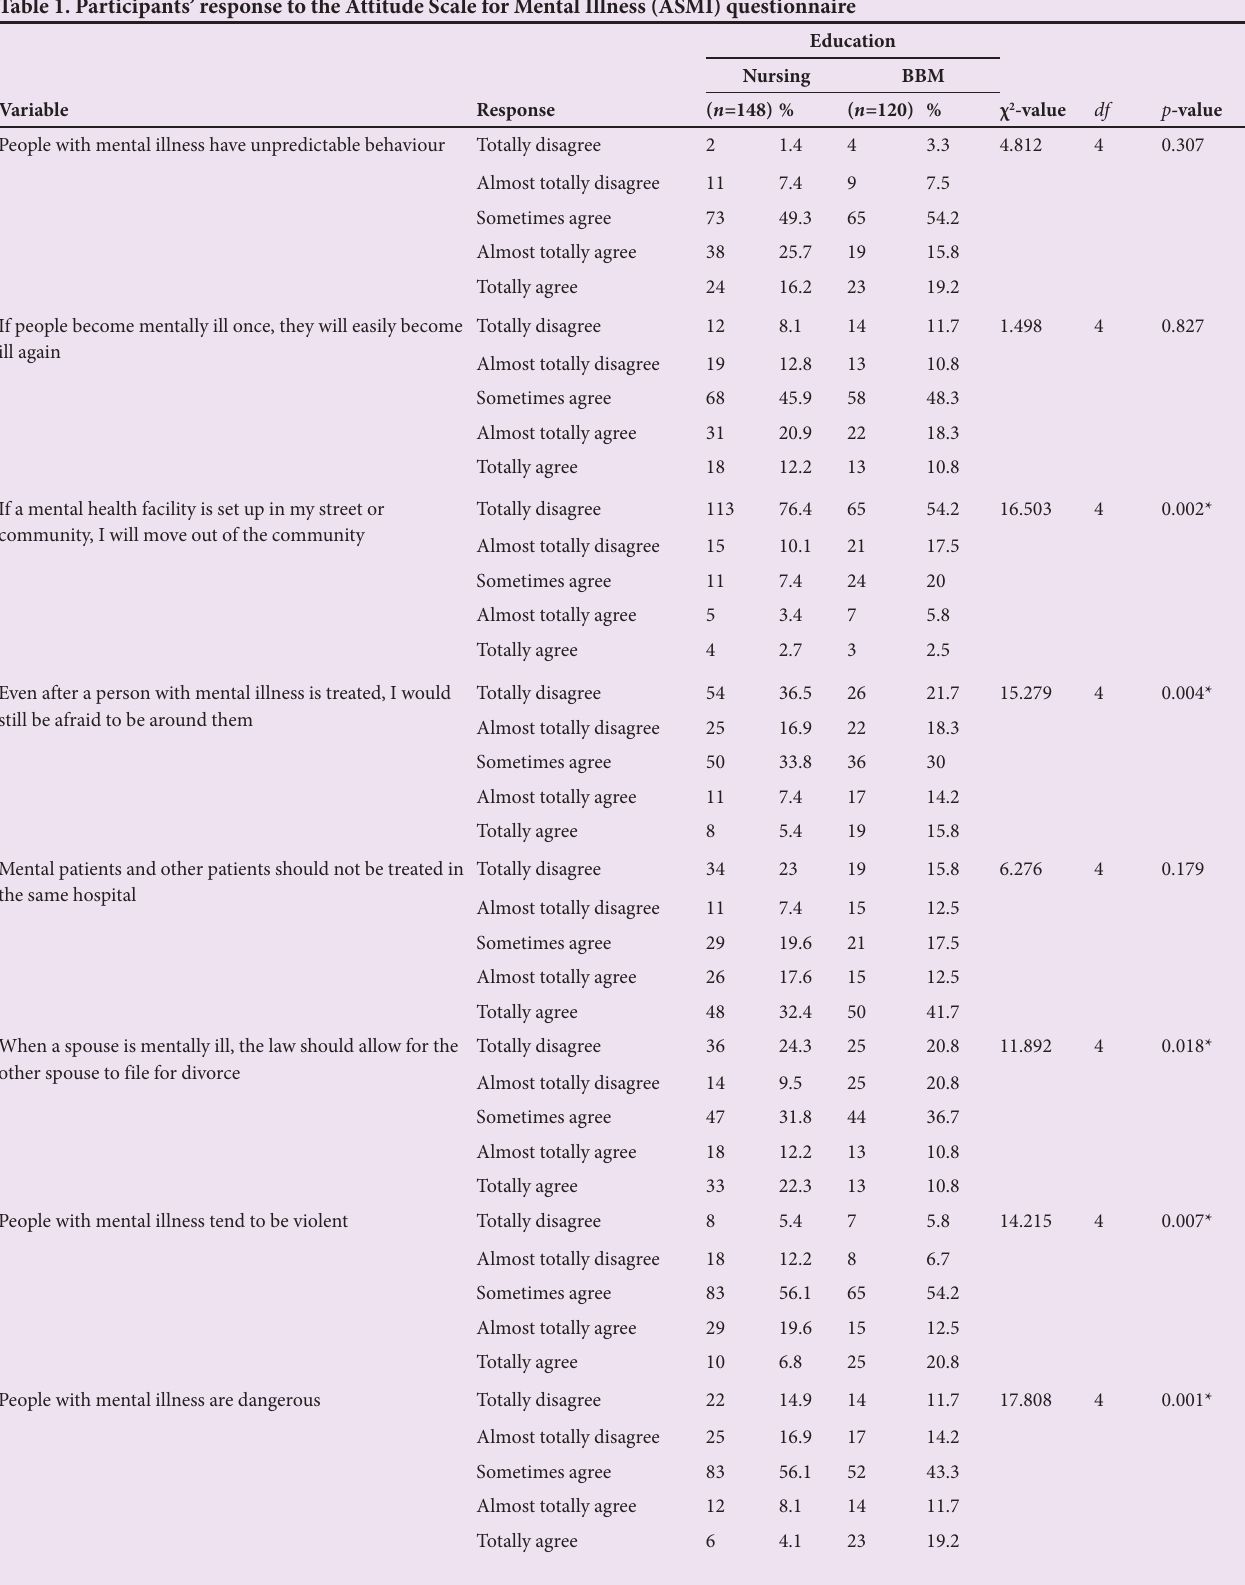
Table 1. Participants’ response to the Attitude Scale for Mental Illness (ASMI) questionnaire